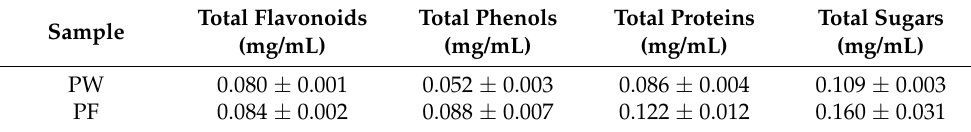
Figure 2. Active substance content of PF and PW. PW: Passiflora edulis Sims peel water extract. PF: Passiflora edulis Sims peel fermentation broth. Each value is expressed as mean ± SD ( n = 3). (*: p < Table 3. Active substance content of PW and PF.